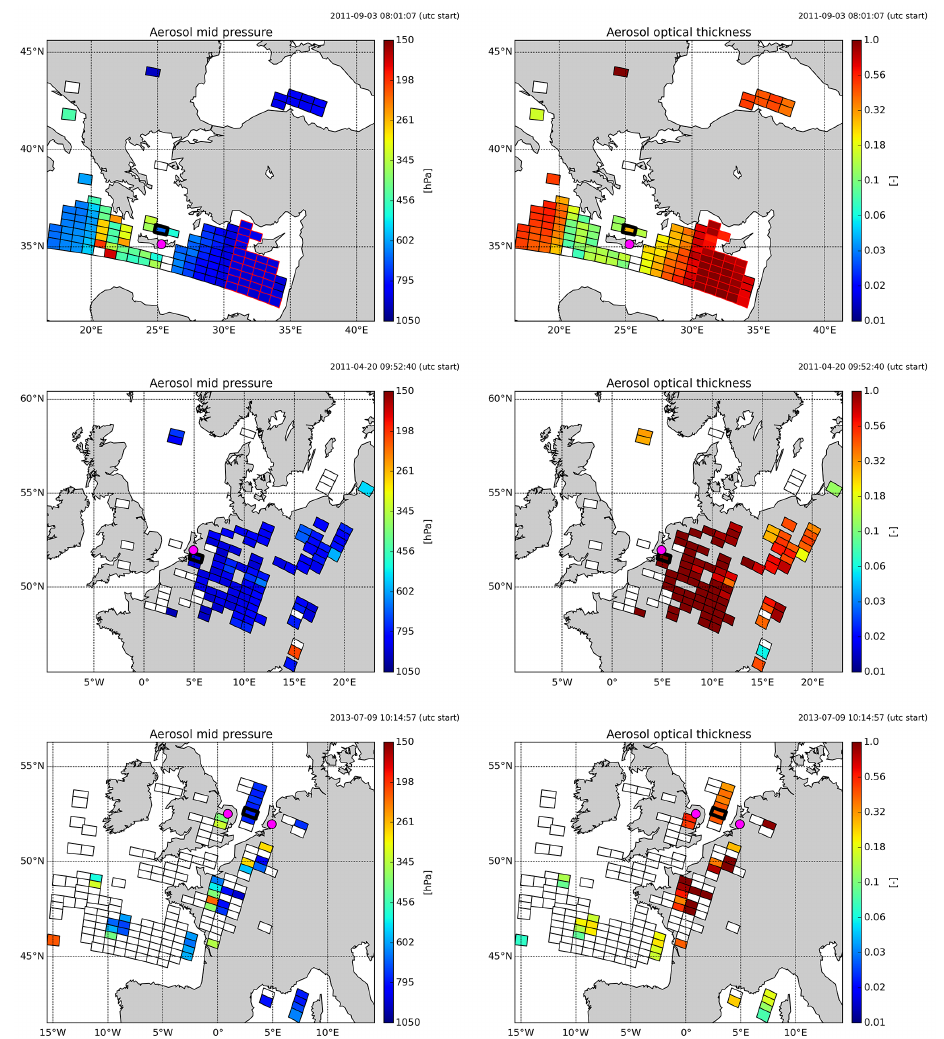
Figure 6. Retrieved aerosol layer mid pressure (left column) and aerosol optical thickness (right column) for three representative GOME-2A scenes (rows) when the surface albedo is fixed in retrieval. The depicted aerosol scenes are (from top to bottom) scene 01, scene 03, and scene 04 from Table 4. Next to P mid and τ (760nm), a temperature offset (cid:49)T is fitted. The layer’s assumed pressure thickness is 50hPa. The model value for the surface albedo is taken from the MERIS black-sky albedo climatology (Popp et al., 2011). Pixels that had no converging retrieval for any of the six attempted runs (i.e., for any of the different sets of initial values) are plotted in white. Missing pixels are pixels that did not pass cloud filtering. The target pixel that is used in the sensitivity experiments of Sect. 8 is depicted with a thick black border. Quadrangles with red borders indicate pixels that are inside the sun glint region. Finally, spatial locations of the lidar measurements are shown with purple dots. Values outside the ranges depicted are